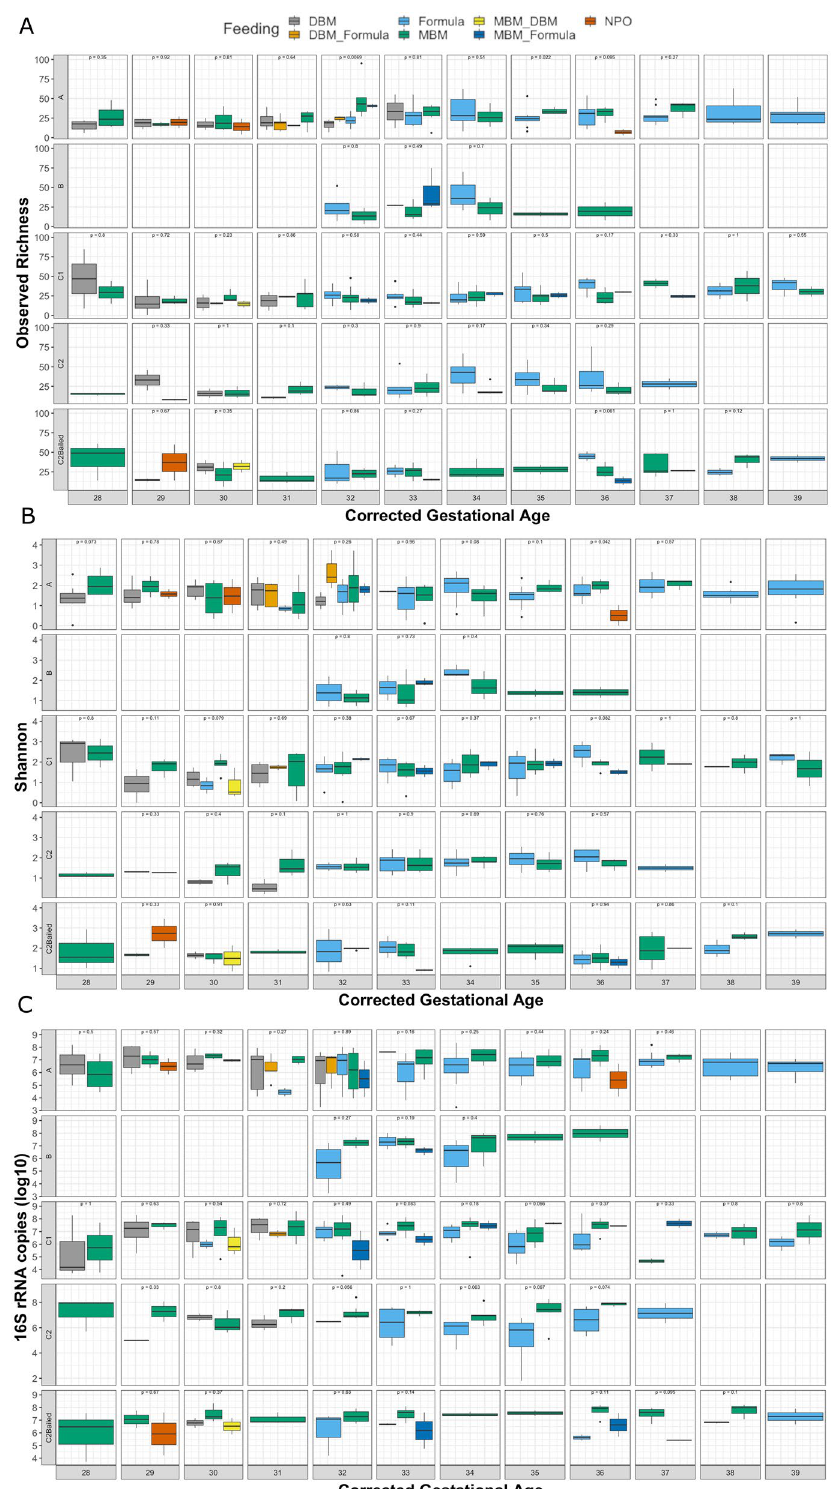
Figure 3. Effects of feeding patterns on the gut microbiome are transient over time. Effect of various feeding patterns on the ( A ) observed ASV richness ( B ) Shannon diversity and ( C ) log 10 -transformed copies of 16S rRNA by enrollment group over corrected GA from weeks 28–39. Only feeding patterns that have at least 2 samples at each timepoint were kept. Statistical comparison of feeding patterns at each corrected GA timepoint was performed using the non-parametric Kruskal–Wallis